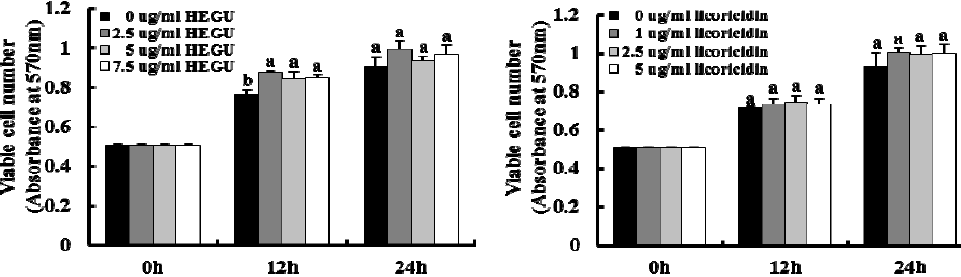
Figure 6. HEGU and licoricidin did not affect the viability of MCF-10A normal mammary epithelial cells. MCF-10A cells were treated as described in Materials and Methods. Cell viability was tested using the MTT assay. Each bar represents the mean ± SEM. Means without a common letter differ, p < 0.05.